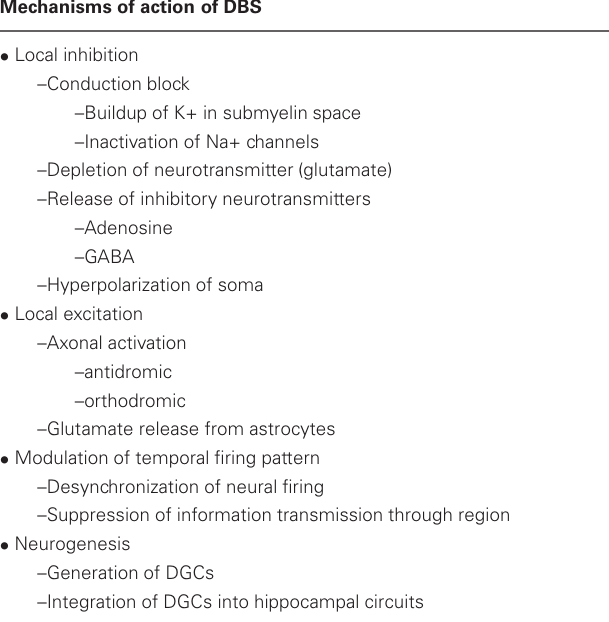
Table 1 | Mechanisms of action of